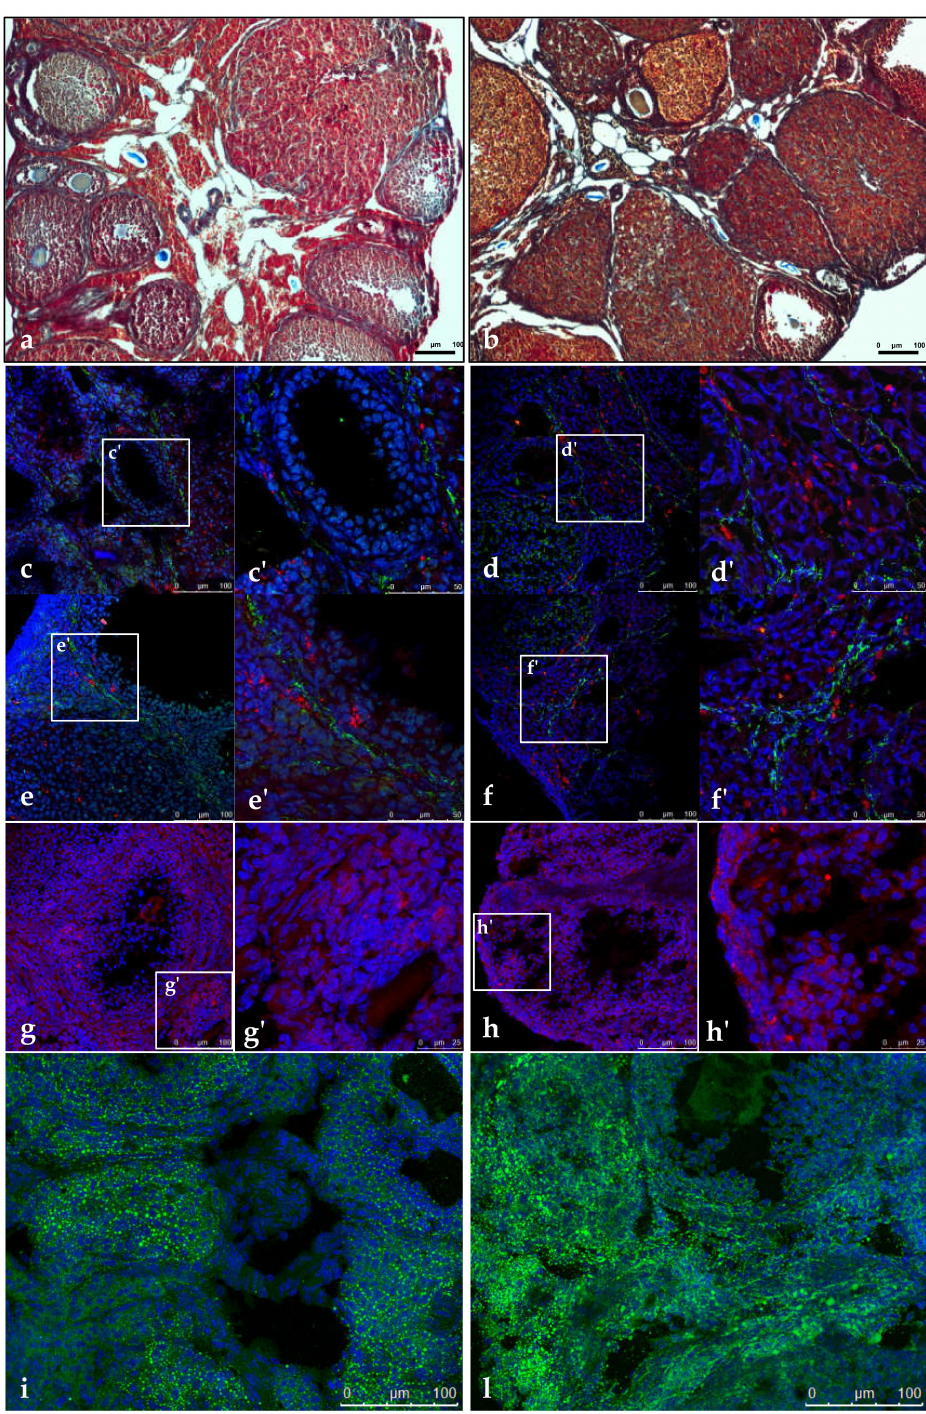
Figure 2. Representative images of trichrome staining in CTRL ( a ) and DHEA ( b ) mice. ( c – f ) Immunolocalization of Von Willebrand Factor (vWF) (green) and alpha smooth muscle actin ( α -SMA) (red) in control ( c , c’ and e , e’ ) and DHEA ( d , d’ and f , f’ ) ovarian sections. ( g – h ) Immunolocalization of 17 beta-hydroxysteroid dehydrogenase type 4 (17 β -HSD4) (red) in control ( g ) and DHEA ( h ) ovarian sections. Staining of lipid droplets by BODIPY 493 / 503 (green) in control ( i ) and DHEA ( l ) ovarian section. ( c – l ) DNA is stained by DAPI (blue). Three mice per experimental group were employed. Experiments were done in